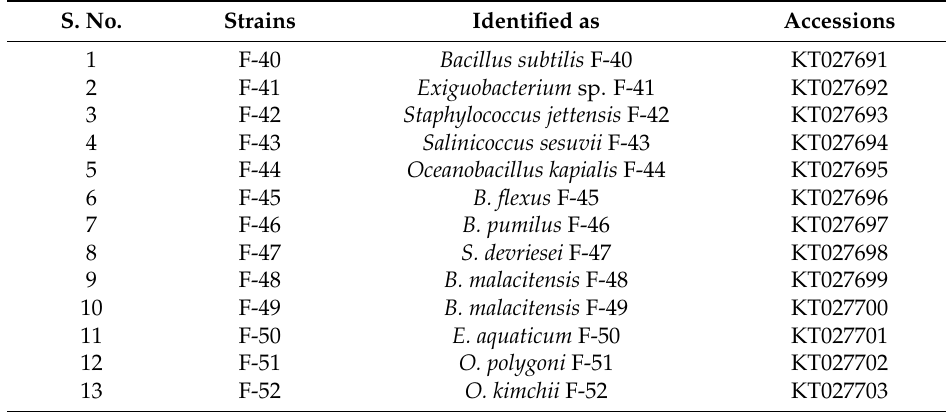
Table 2. 16S rRNA gene sequencing of halotolerant bacterial strains isolated from the phytoplane of S.